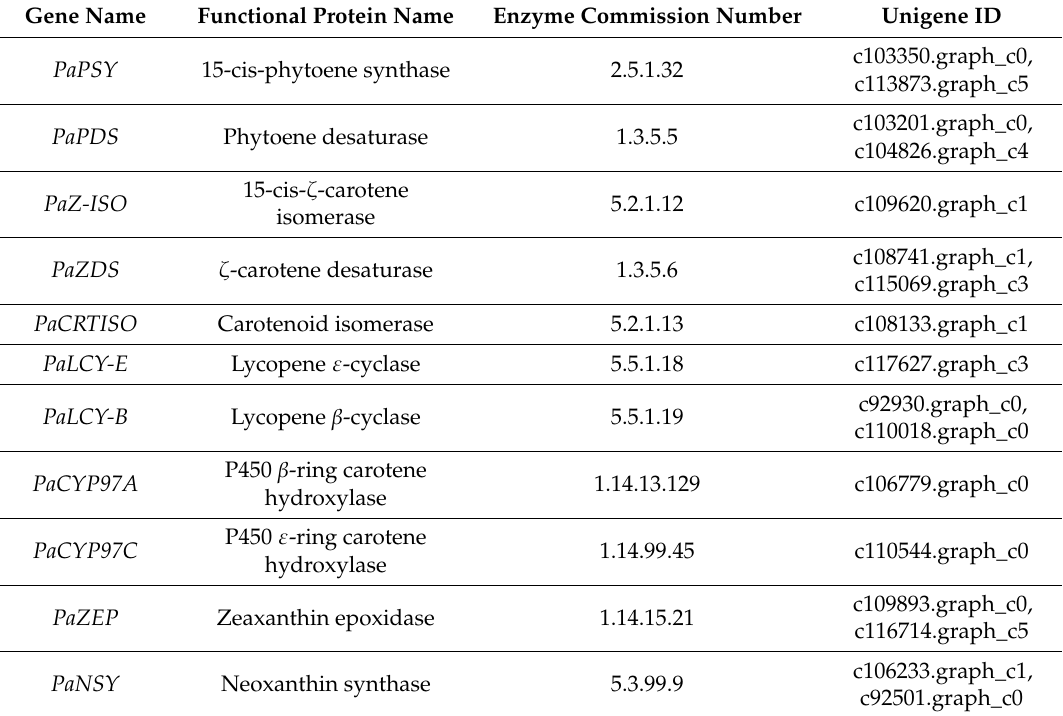
Table 1. Unigenes related to carotenoid